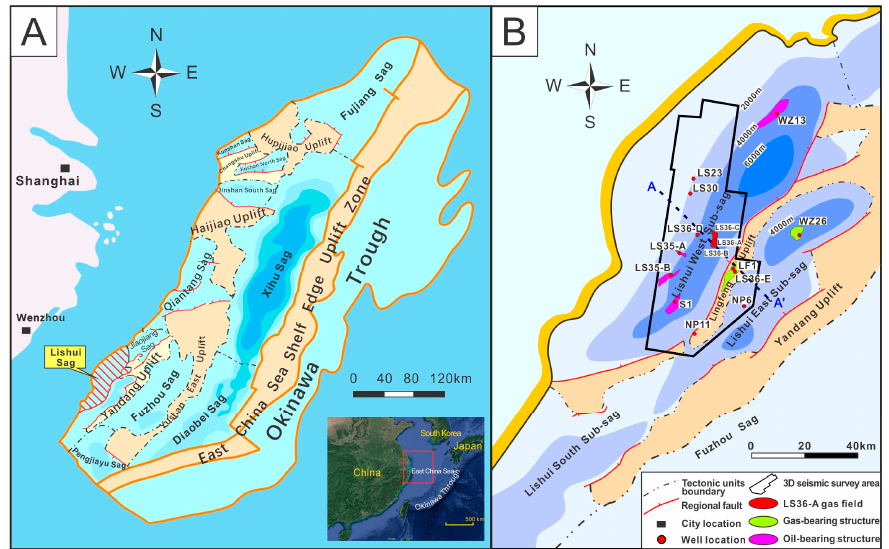
Figure 1. Location and geographic setting of the study area (Modified after Liu [9]). ( A ) Structural and tectonic elements of the East China Sea Shelf Basin. ( B ) Structure division of the Lishui Sag and study area outlined in the red box.